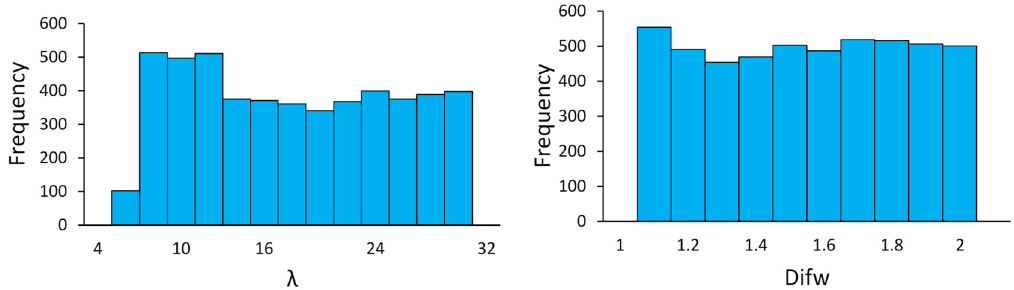
Figure 3. Posterior distribution of solute transport parameters: Difw = diffusion coefficient and λ = dispersivity. The x -axises of the plots are fixed to prior distribution (range) of the parameters.